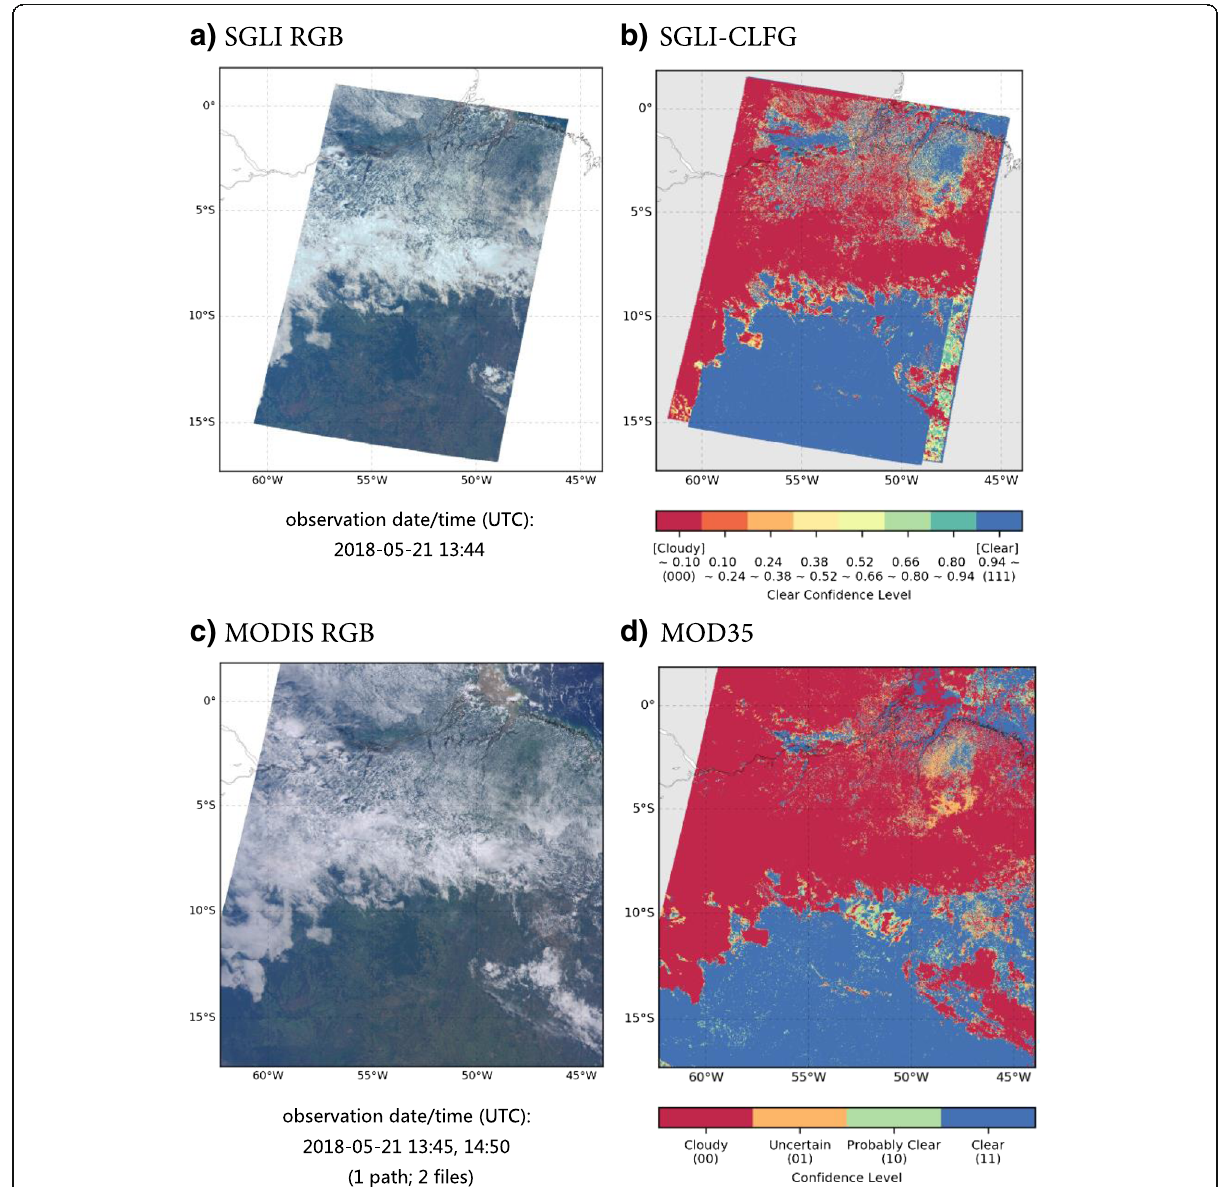
Fig. 14 Same as Fig. 12, but over the Amazon forest on May 21,